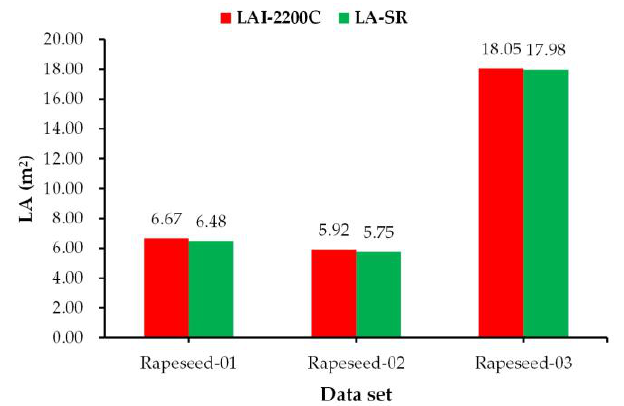
Figure 7. Statistical bar graph of total LA estimates for LAI-2200C and LA-DT. Table 2. Paired samples t -test of LA of LAI-2200C and LA-DT for 3 groups of field rapeseeds.